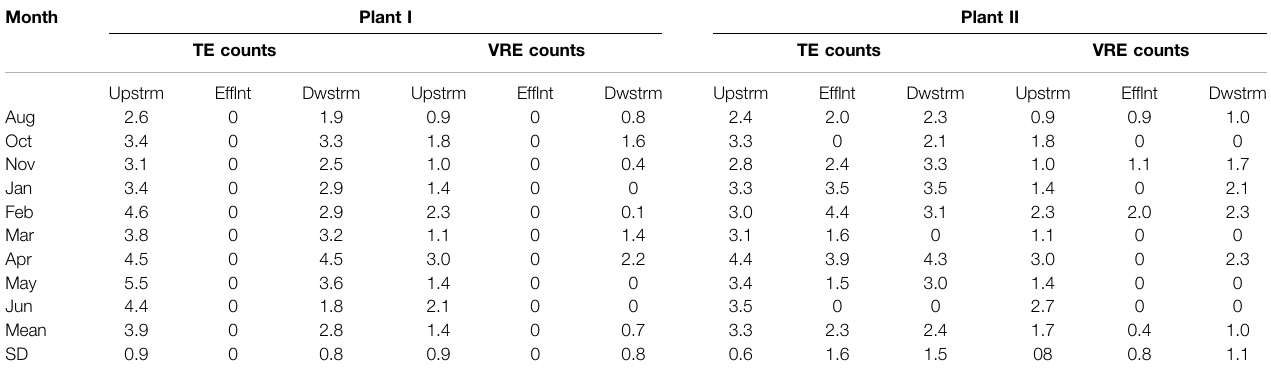
TABLE 4 | Comparison of the ef fl uent, upstream and downstream counts of the presumptive